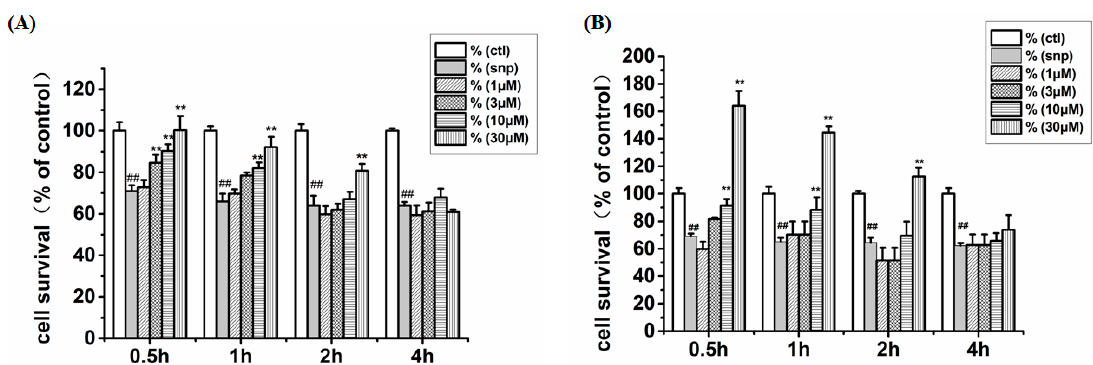
Figure 4. Effects of CHR20/21 against SNP–induced insults in RGC-5 cells. RGC-5 cells were pre-treated with SNP at a concentration of 750 μ mol/L for 0.5, 1, 2, and 4 h, respectively, then exposed to various concentrations of CHR20 ( A ) and CHR21 ( B ), respectively, for another 24 h. MTT activity was determined by MTT assay. The percentage of MTT activity was presented as mean ± SD for six replicates. ## p < 0.01 vs. control group, ** p < 0.01 vs. SNP-treated group.